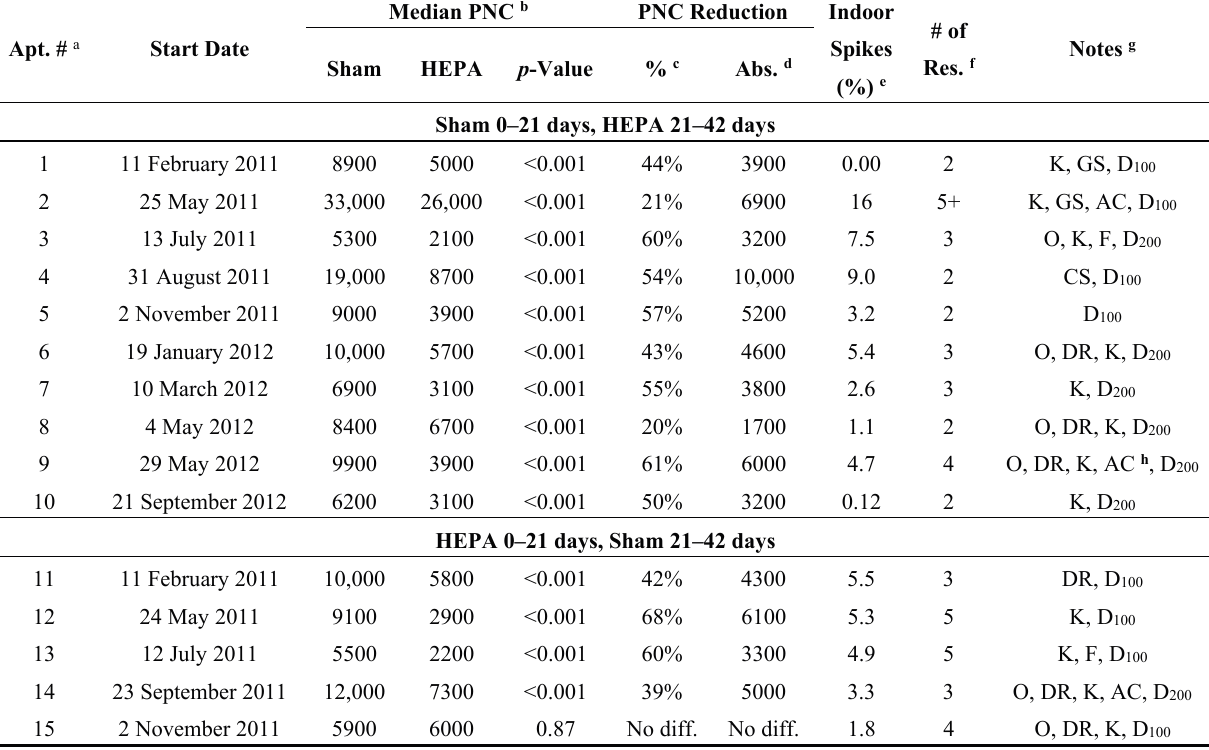
Table 2. Summary of PNC measurements for each